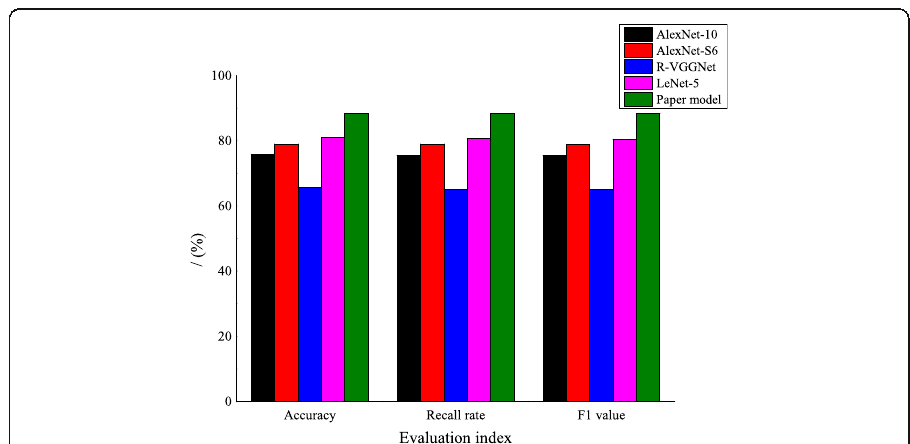
Fig. 10 Comparison of the evaluation indices among different